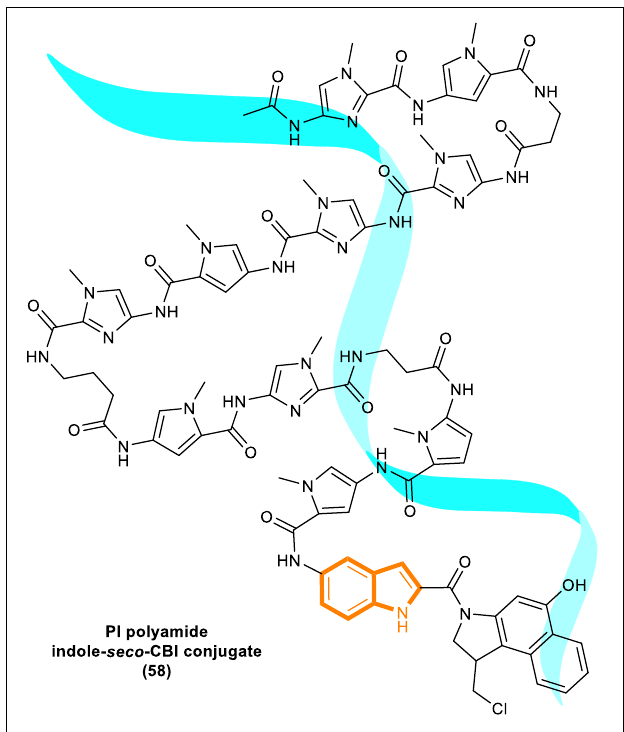
FIGURE 12 | Structure of PI polyamide indole- seco -CBI